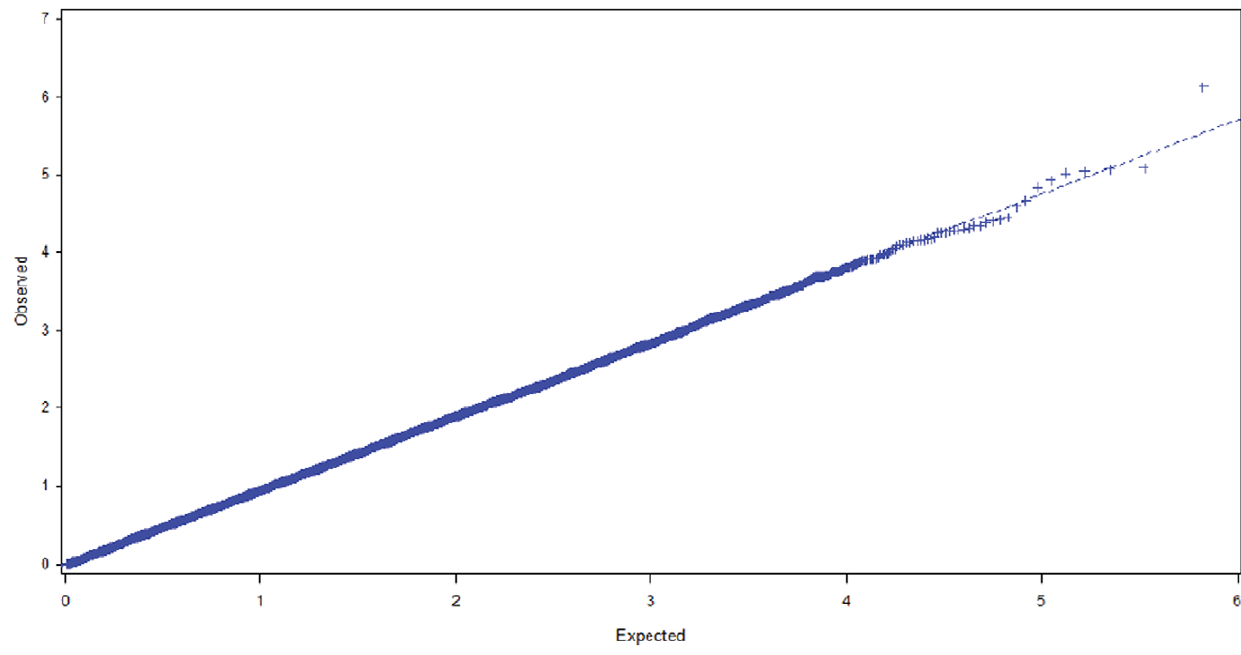
Figure 1. Quantile-quantile (Q-Q) plot of the observed versus expected –log 10 (p) values for the meta-analysis. Y-value: observed test statistic and X-value: expected statistic under the global null hypothesis of no association.